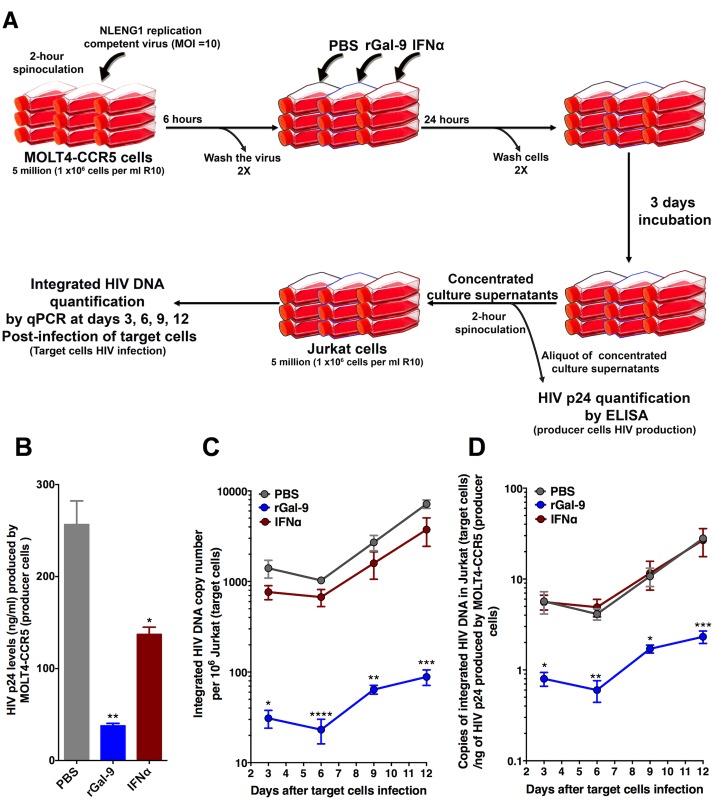
rGal-9 treatment reduces viral infectivity.(A) Illustrative schematic of the viral infectivity experiment. (B-D) Effects of rGal-9 treatment of producer cells on HIV infectivity. The MOLT4-CCR5 cell line was infected for 6 hours, cells were washed and treated with either PBS, rGal-9 200nM, or interferon-α (5000 U/ml) for 24 hours, and cultures were incubated for 3 days. (B) HIV p24 levels produced by MOLT4-CCR5 cells were quantified after concentrating the culture supernatants. Concentrated culture supernatants were used to infect Jurkat cells by spinoculation. (C) Levels of integrated HIV DNA measured at days 3, 6, 9, and 12 post-infection of Jurkat cells. (D) Levels of integrated HIV DNA at days 3, 6, 9, and 12 post-infection of Jurkat cells, normalized to producer cell p24 supernatant levels. Mean ± SEM is displayed, and statistical comparisons were performed using two-tailed unpaired t test. * = p<0.05; ** = p<0.01, *** = p<0.001, and **** = p<0.0001.